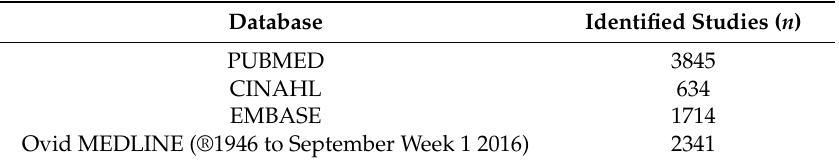
Table 3. Databases and search results prior to screening and removal of